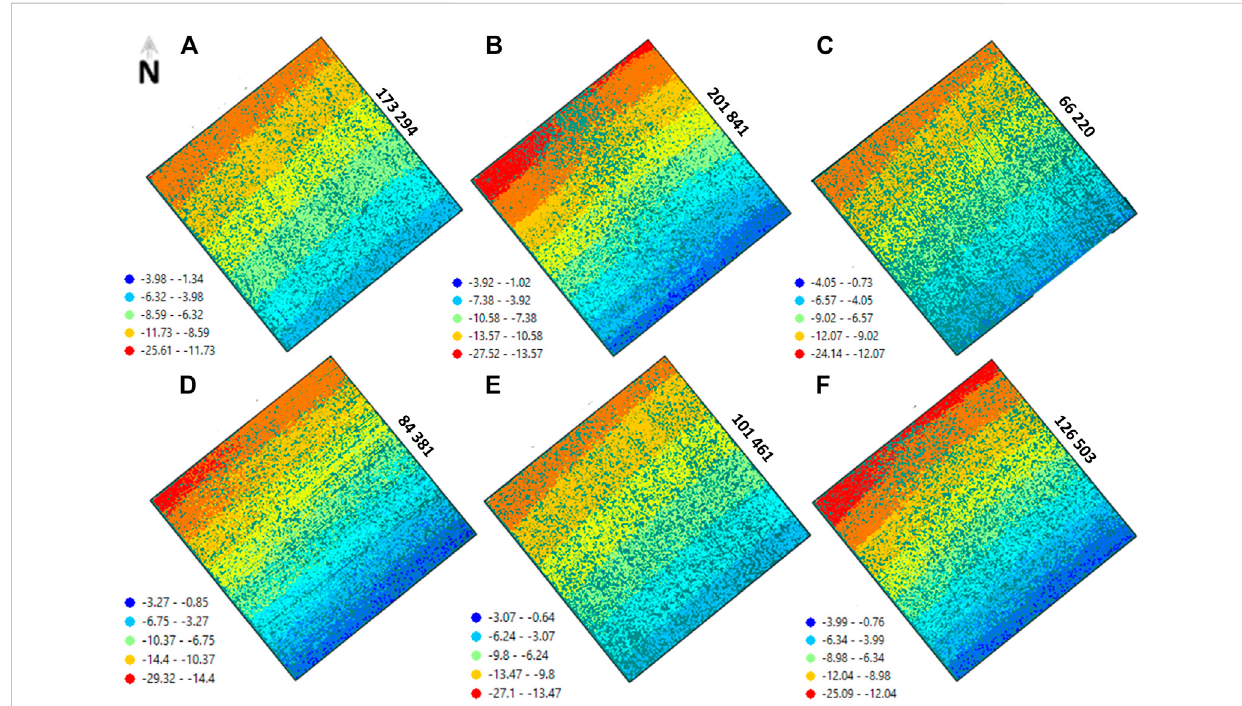
FIGURE 7 Un fi ltered data of the acquired dense point clouds in different MBES survey (A) speed 1.5 knots direction NE - SW; (B) speed 1.5 knots direction SE - NW; (C) speed4.5knotsdirectionNE-SW; (D) speed4.5knotsdirectionSE-NW; (E) speed3knotsdirectionSE-NW; (F)